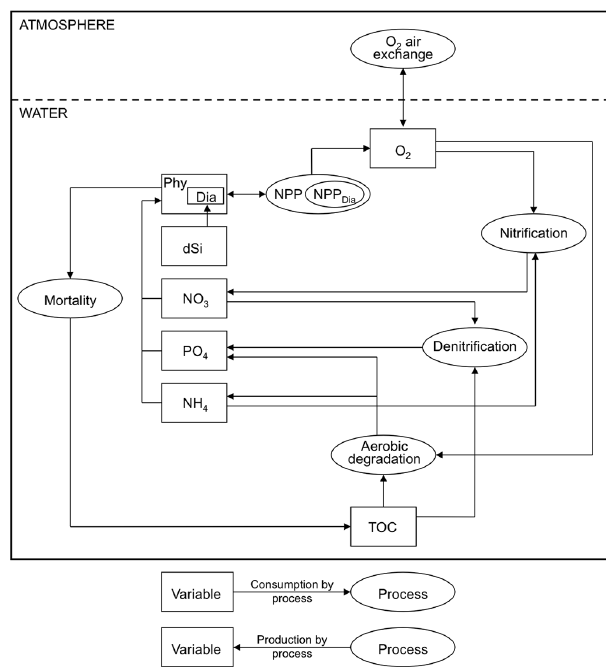
Figure 4. Conceptual scheme of the biogeochemical module of C-GEM, as used in our applications to the Scheldt estuary (see Sect. 4). State variables and processes are represented by boxes and circles, respectively. DIA corresponds to